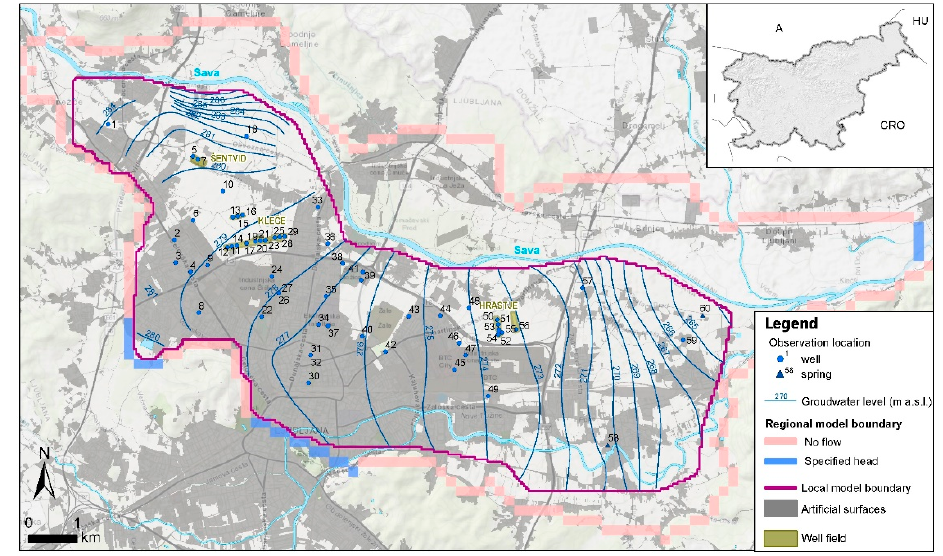
Figure 1. Map of the study area showing observation locations, groundwater level isolines, model boundaries, artificial surfaces, and well